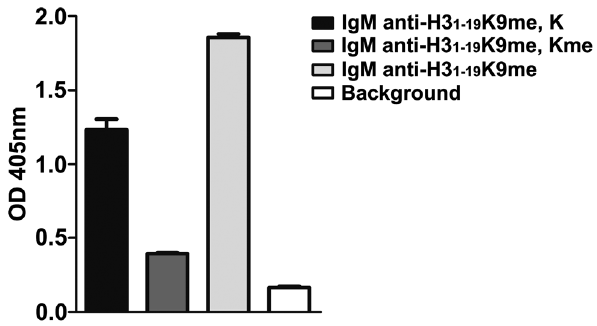
Figure 8. Reactivity of anti-H3 1 – 19 K9me IgM against histones. Microtiter plates were coated with histones. IgM Abs purified from the H3 1–19 K9me beads with or without prior absorption with lysine or mono-methylated lysine were tested. Background wells were not added with purified IgM. KT16 anti-human IgM was used as the primary Ab and HRP-conjugated goat anti-mouse IgG was used as the secondary Ab. Data are expressed as mean + SEM. The results are representative of three separate